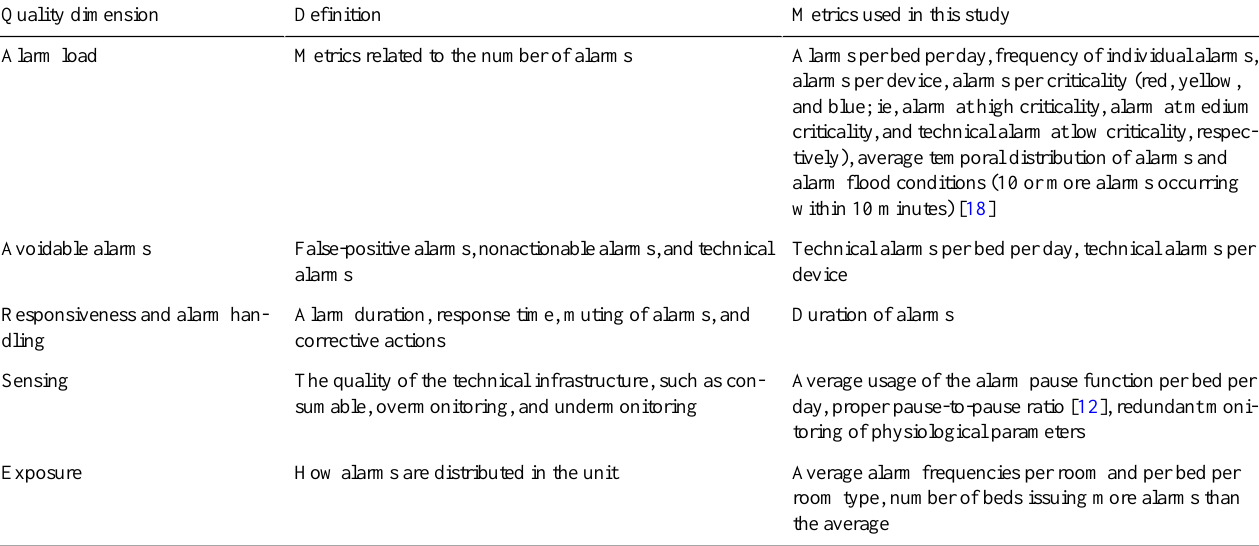
Table 1. Data analysis framework applied in this study in line with the quality dimensions introduced by Hüske-Kraus et al [12] and including metrics suggested by Hüske-Kraus et al [12] as well as metrics suggested by other sources for each dimension, wherever possible.